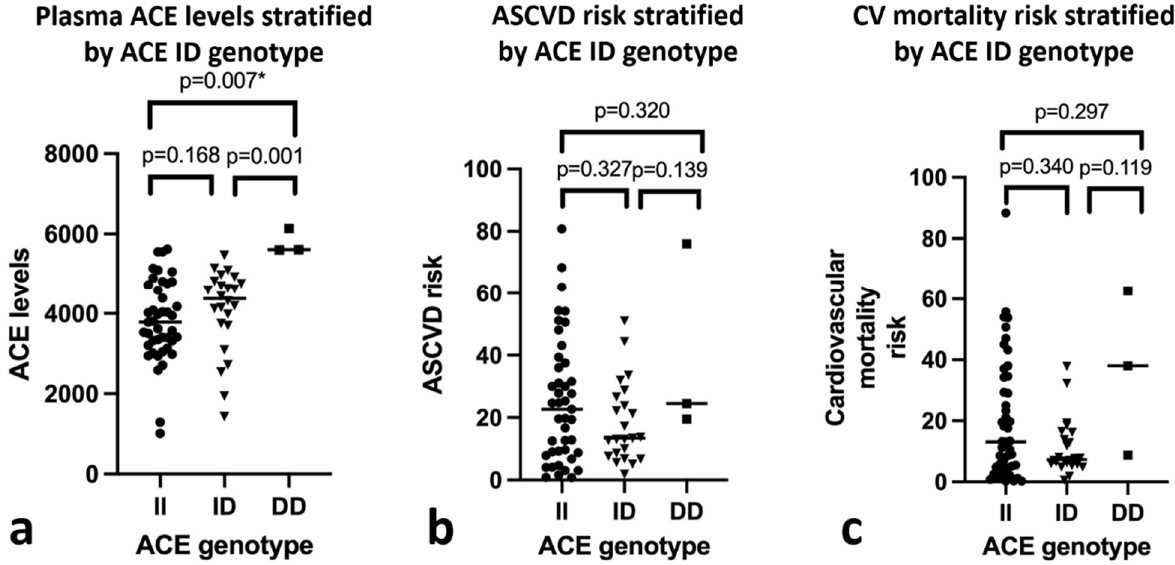
Figure 5. Analysis of ACE levels, ASCVD risk, and cardiovascular mortality risk between different ACE I/D genotypes (Kruskal–Wallis with Mann–Whitney post-hoc test). ( a ). Patients with DD genotype displayed higher plasma ACE levels compared to II or ID genotypes. ( b ). No difference was observed in ASCVD risk between the three genotypes. ( c ). No difference was observed in cardiovascular mortality risk between the three genotypes. * = significant at p < 0.05